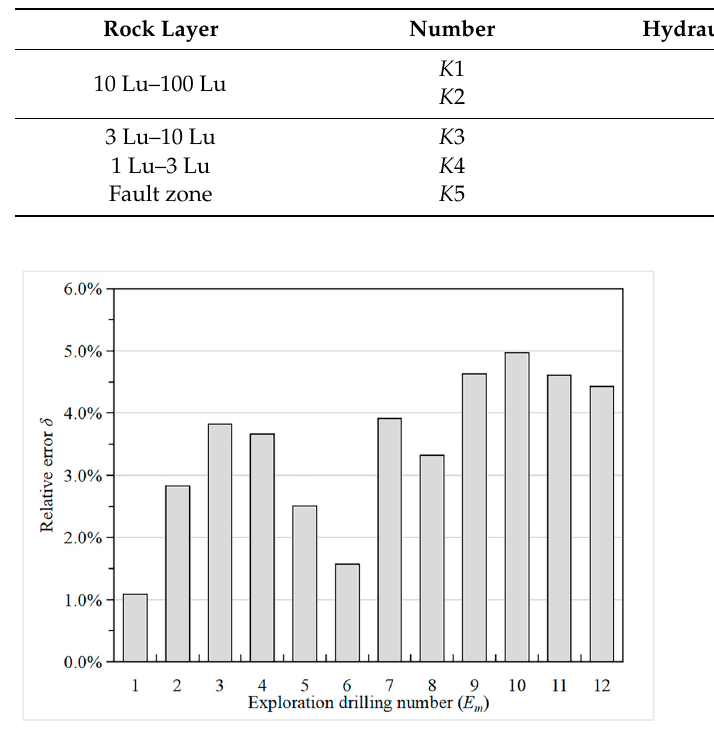
Figure 7. The relative error between the drilling water head and the calculated water